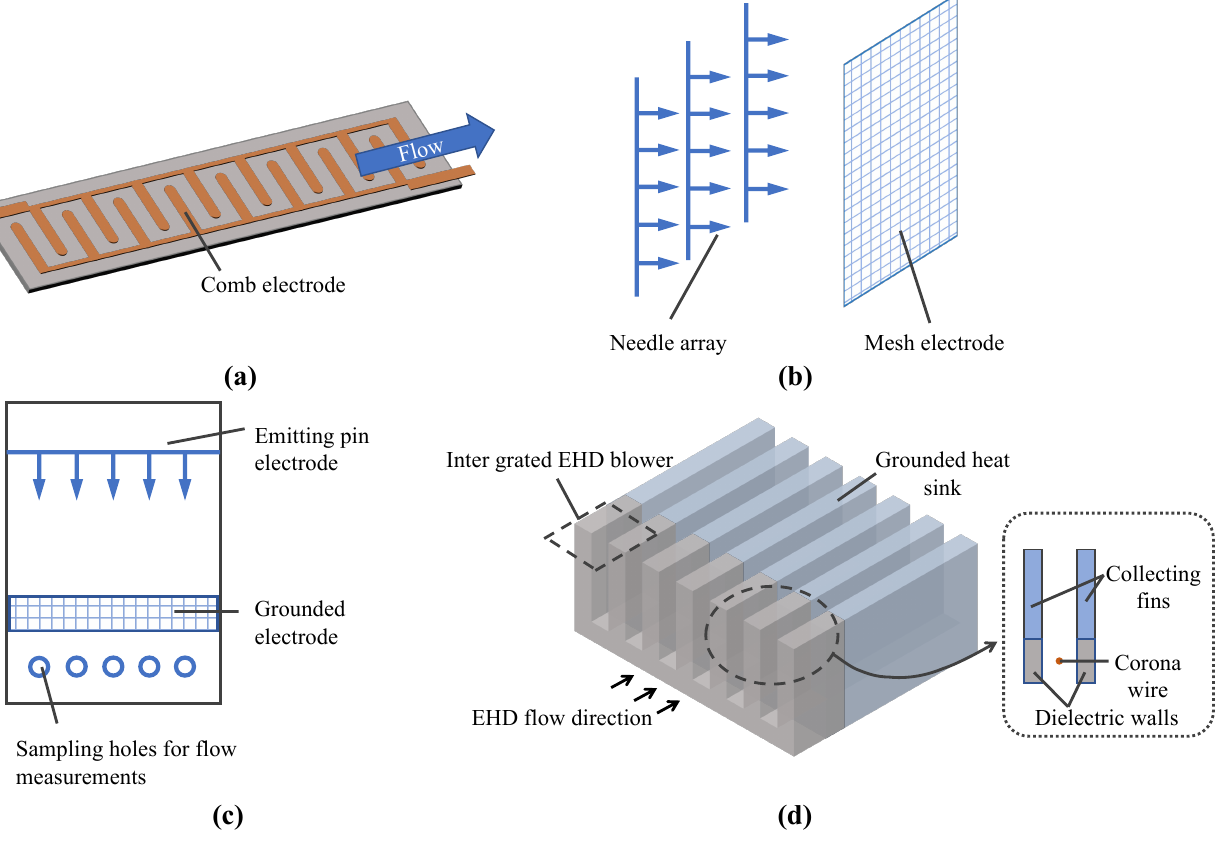
Figure 8. Cooling device. ( a ) Pump produces significant flow rates with and without bending [151] ( b ) Air pump for multi-parameter testing [152] ( c ) Multiple single-stage EHD air pumps [153] ( d ) Notebook computer cooling system